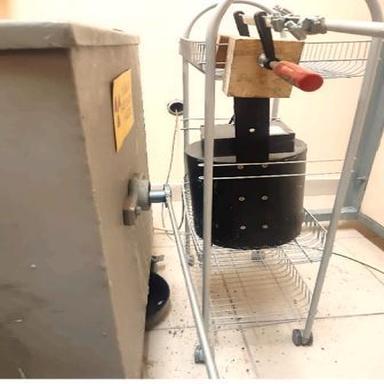
(a–b). Experimental setup for (a) gamma-ray and (b) neutron transmission measurements.